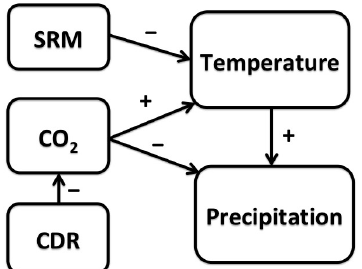
Figure 5. A schematic presentation of fast radiatively induced and slow temperature-induced components of SRM and CDR. Plus and minus signs indicate the direction of change in the target variable when the driving variable is increasing. If the driving variable is decreasing (e.g. temperature decrease due to SRM), the target vari- able changes in the opposite direction as indicated (e.g. decrease in precipitation due to decreased temperature). The fast component of SRM is so small compared to that induced by changes in the CO 2 concentration that it is omitted for